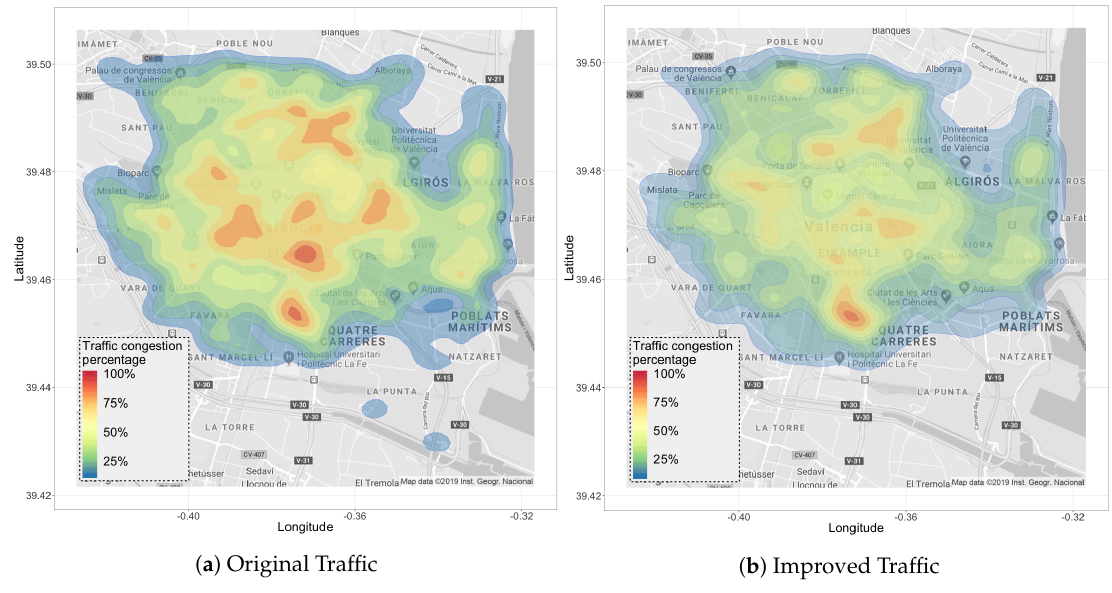
Figure 5. Heatmap of traffic congestion for the city of